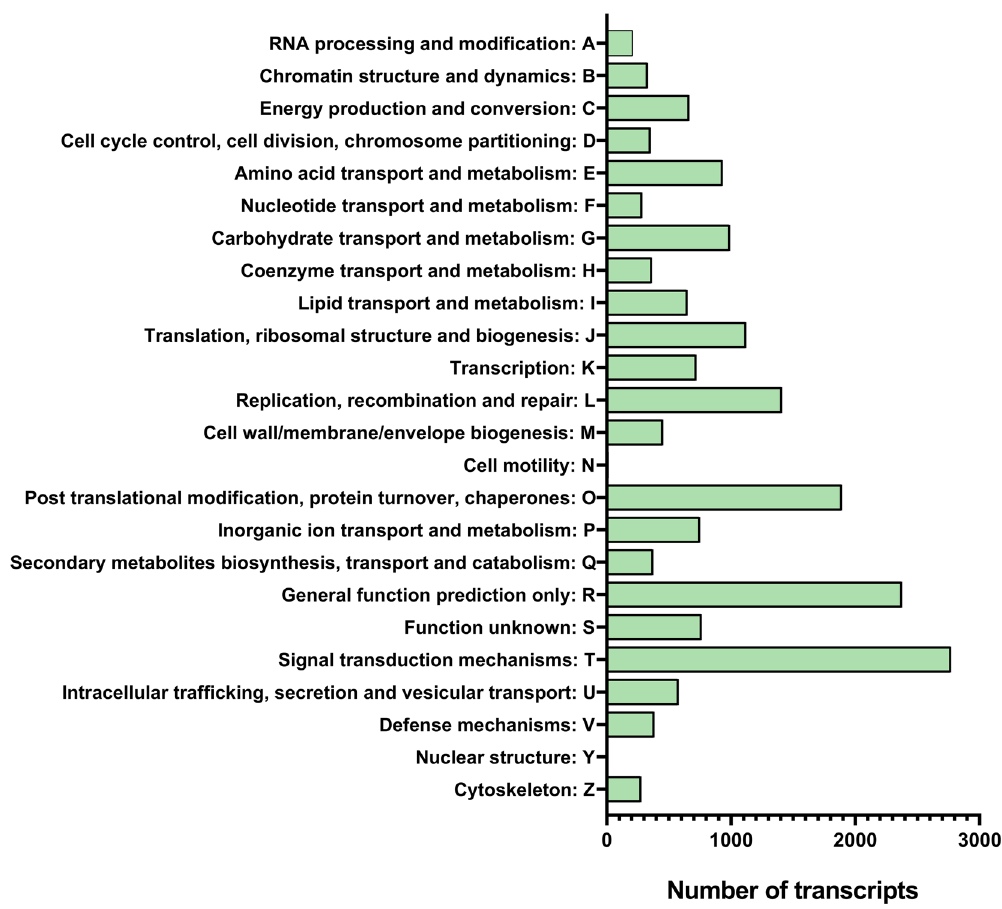
Figure 1. COG classification of D. cymosum transcripts. A total of 19,085 transcripts were identified by the eggNOG database. Of these, 18,690 were categorised into 25 COG